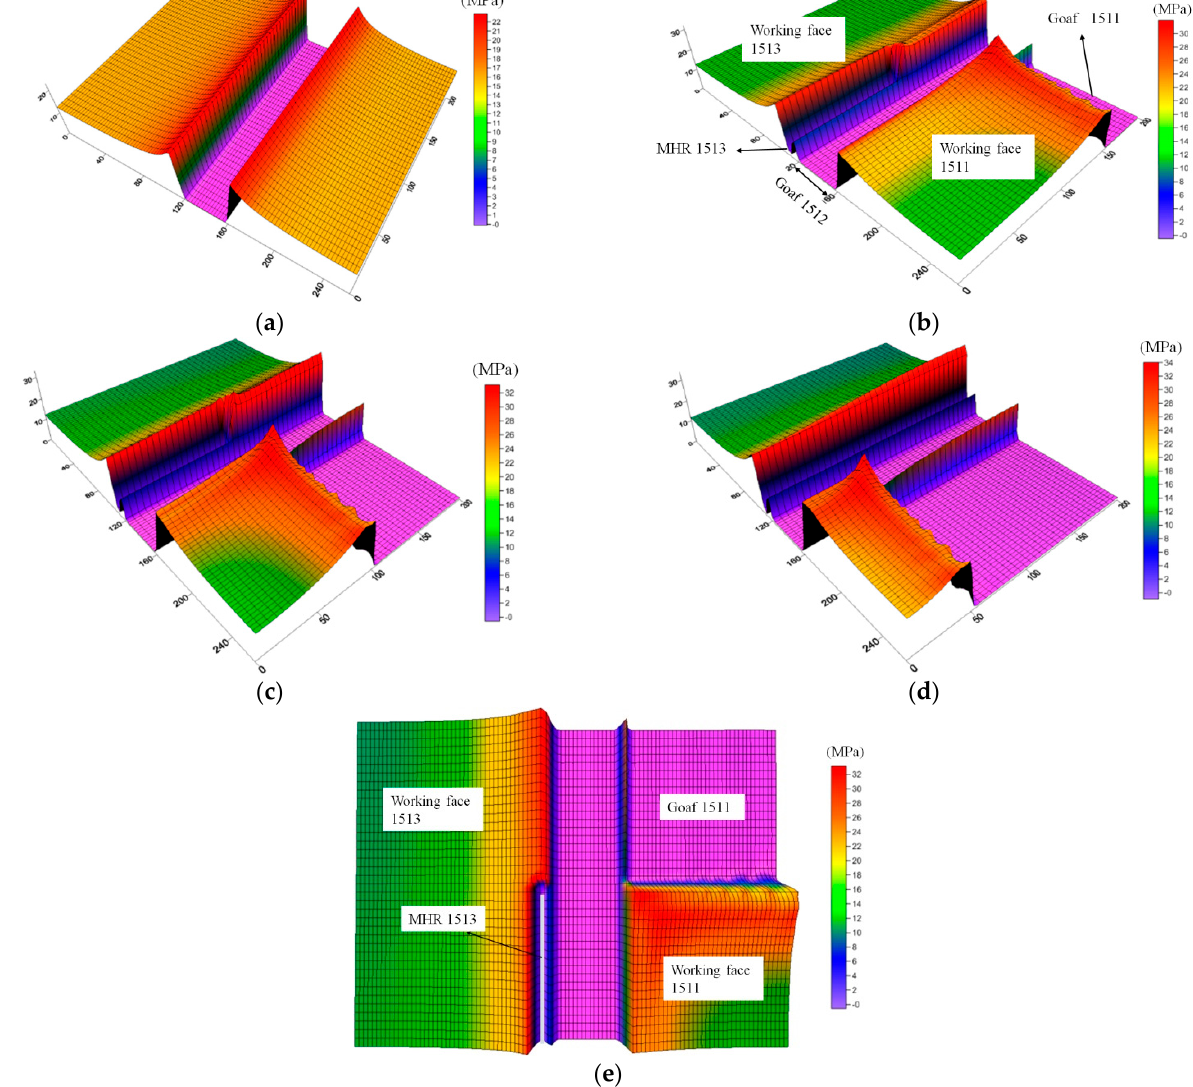
Figure 4. Stress evolution characteristics of gob-side roadway driving under face mining: ( a ) mining working face 1512, then forming a goaf with a width of 40 m; ( b ) excavating 100 m of roadway, mining 50 m of working face 1511; ( c ) excavating 100 m of roadway, mining 100 m of working face 1511; ( d ) excavating 200 m of roadway, mining 150 m of working face 1511; ( e ) prone view of ( c ).